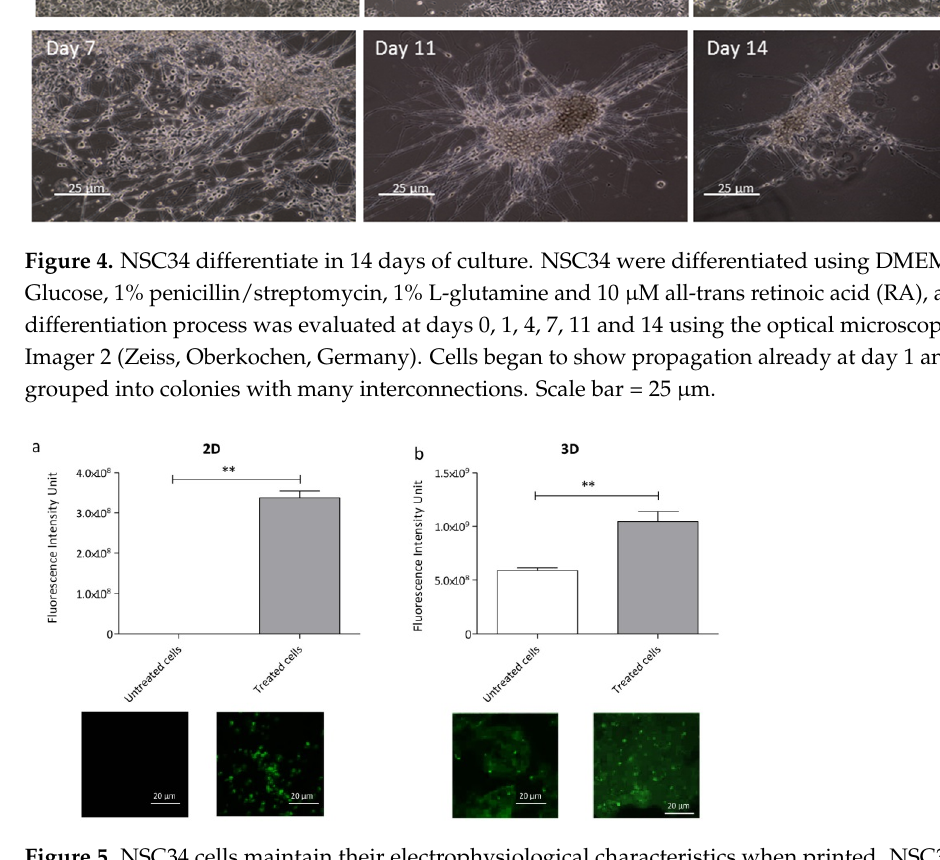
Figure 5. NSC34 cells maintain their electrophysiological characteristics when printed. NSC34 cells were induced to fire with 15 mM KCl both in 2D ( a ) and 3D ( b ). Then, an immunofluorescence analysis using the neuronal marker c-fos was performed. Data show that the hydrogel does not interfere with the firing capacity of printed NSC34. Error bars indicate SD. Data were analyzed using a t-test followed by the Mann–Whitney test. ** p < 0.01 (GraphPad Prism 8). Scale bar = 20 μm.